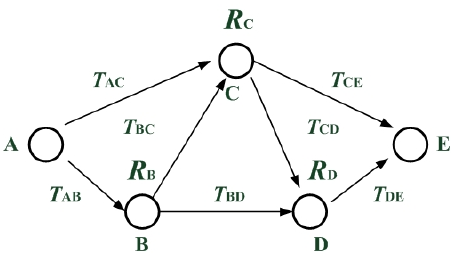
Figure 1. An example of WSN.